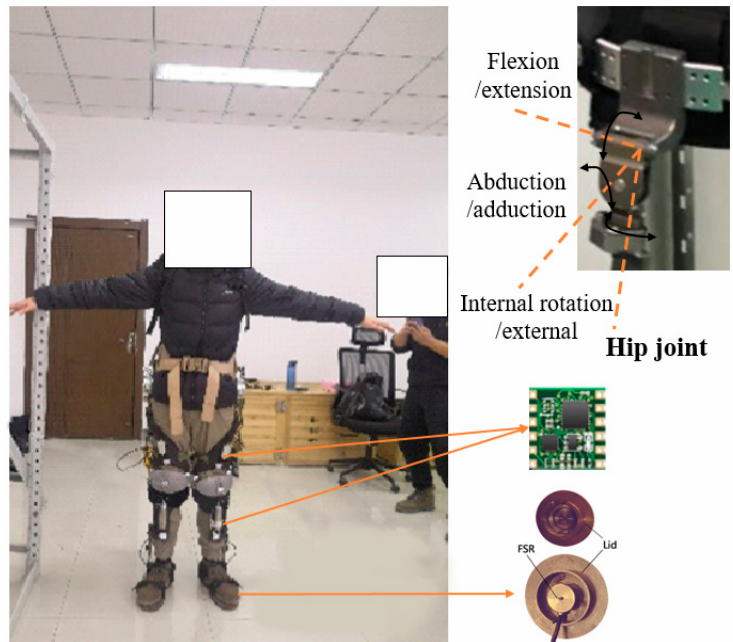
Figure 1. The lower extremity exoskeleton robot of BIT.